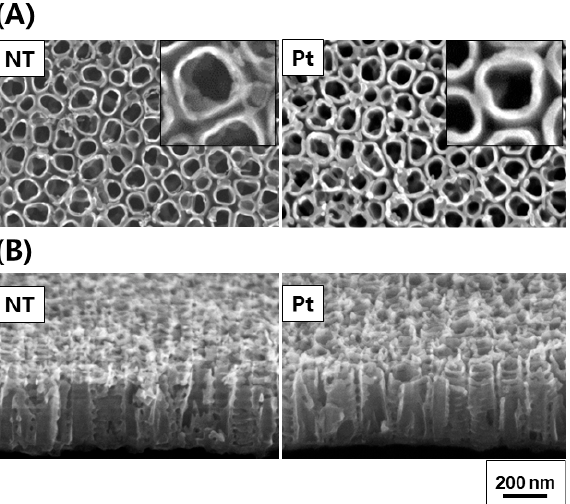
Figure 2. FE-SEM plain ( A ) and oblique views ( B ) of TiO 2 NT and Pt-TiO 2 NT (inset: magnified plain view).